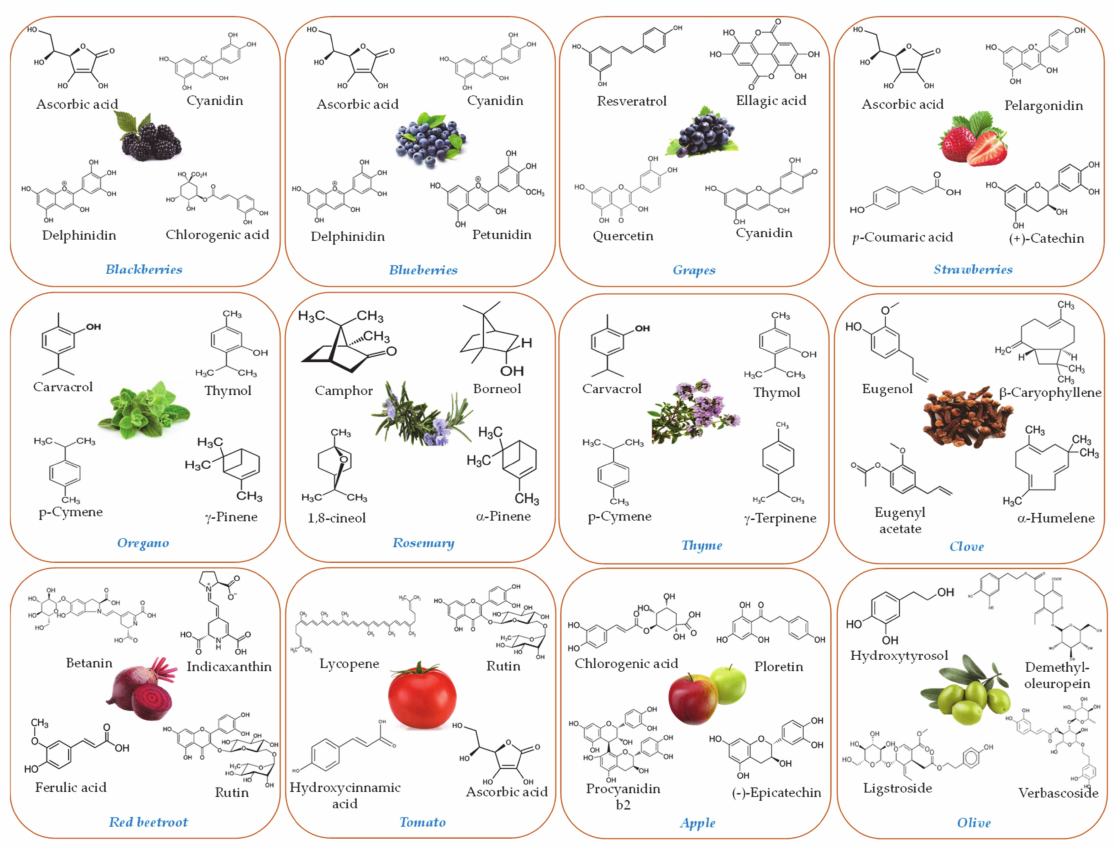
Figure 1. Examples of some important bioactive agents isolated from edible plant